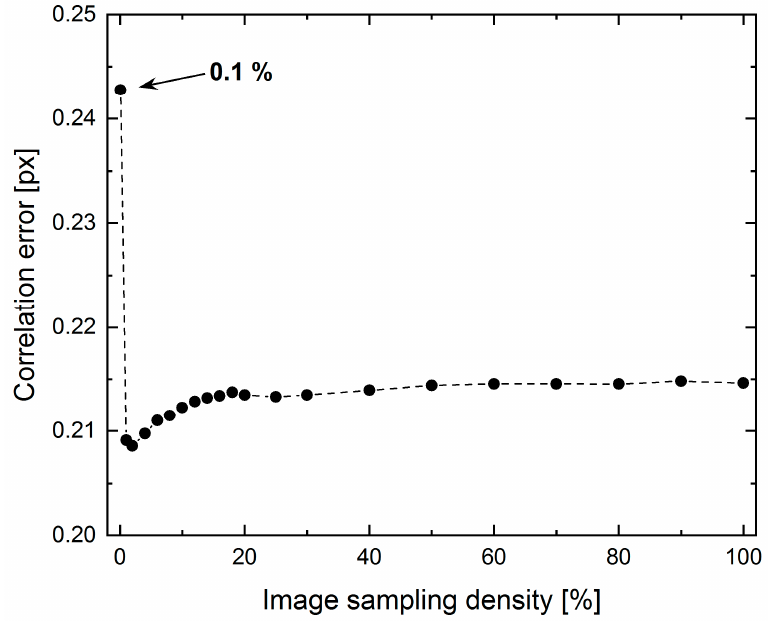
Figure A4. Correlation error with respect to the amount of image voxels used for similarity metric calculation after each iteration. calculation after each